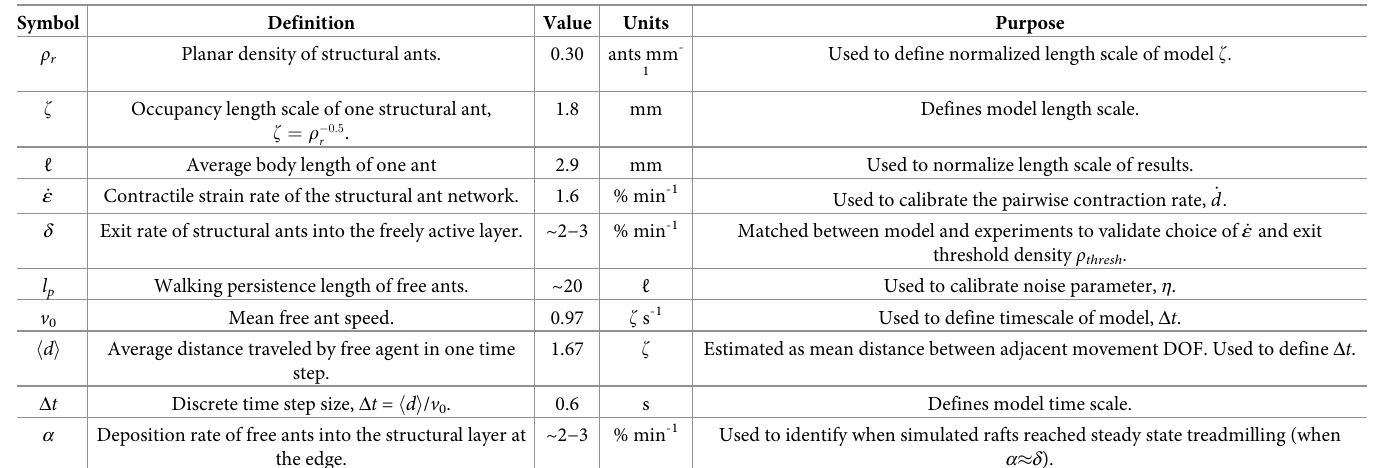
A summary of experimental and numerical values used throughout this work is provided in Table 1 . Experimental values of Table 1 were taken from Wagner, et al. (2021) [14]. A summary of the model’s free parameters is provided in Table 2 . The structural agent model contains just one free parameter, the contraction rate between nearest neighbors ( _ d ). However, this value was fixed to reproduce the global contraction rate, _ ε , of experimentally observed rafts [14]. The freely active agent model has three free parameters: (1) the radius of mutual influence between an agent and its nearest neighbors ( R ); (2) activity ( A ); and (3) the noise parameter ( η ). However, R and η were fixed to match the walking characteristics of experimental ants (See the Model Calibration section, below).